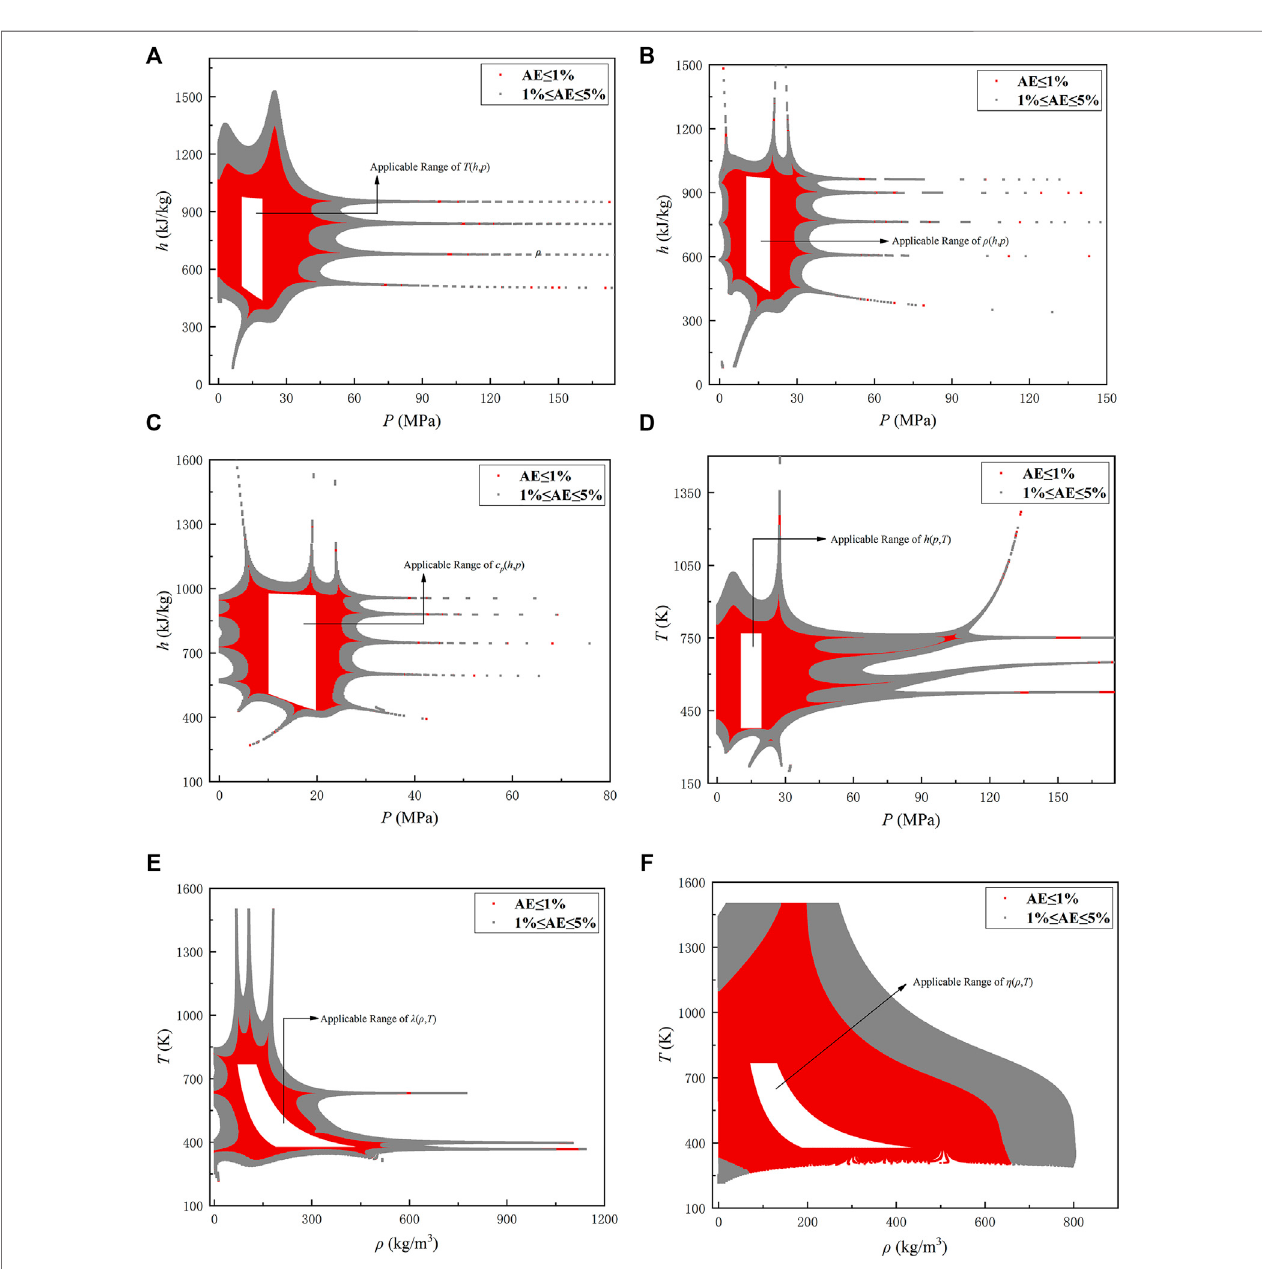
FIGURE3| Distribution ofworkingpoints withabsoluteerrorless than1%foreach formula: (A) T ( h , p ) (B) ρ ( h , p ) (C) c p ( h , p ) (D) h ( p , T ) (E) λ ( ρ , T ) (F) μ ( ρ , T ) .